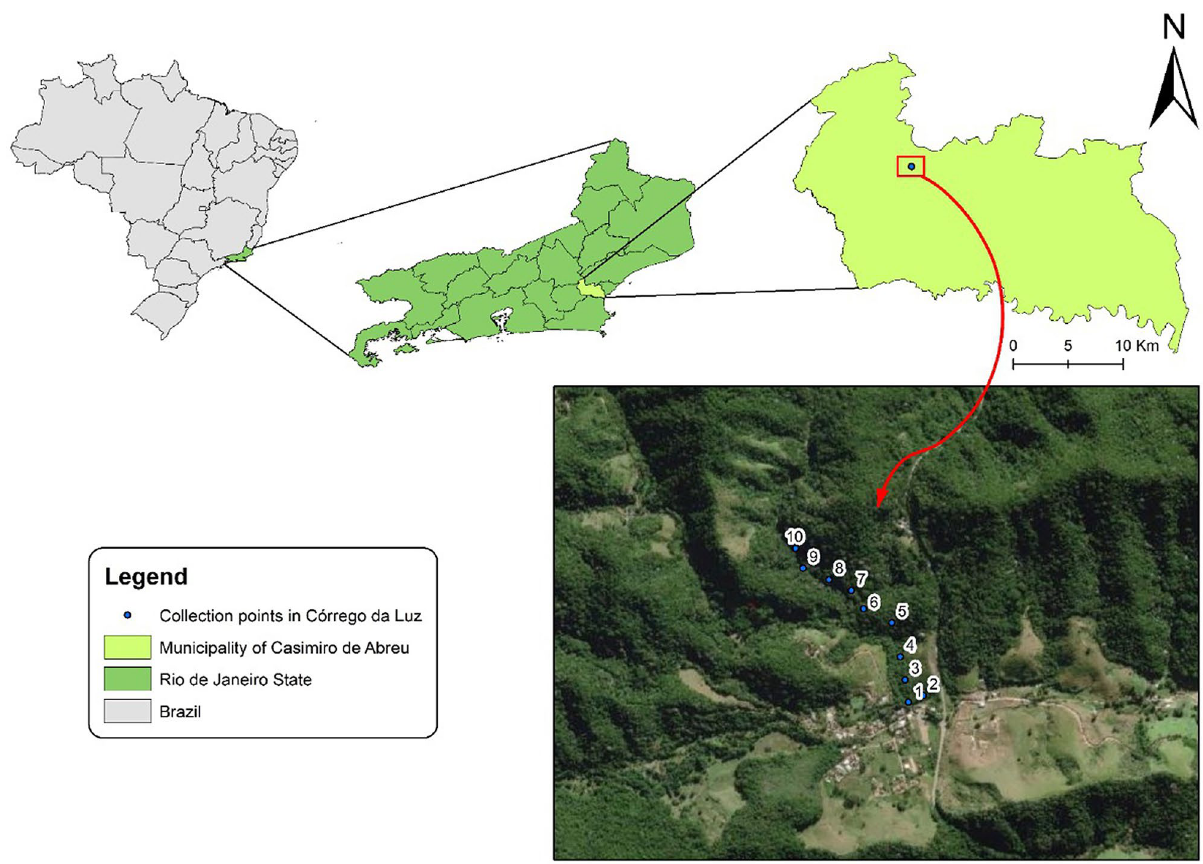
Figure 3. Sampling sites in the Córrego da Luz Municipal Park, located in the city of Casimiro de Abreu, Rio de Janeiro state, Brazil. Maps were prepared in ArcGIS Desktop: Release 10.5. Redlands, CA (ESRI) (https ://www. esri.com/en-us/arcgi s/produ cts/arcgi s-pro/overv iew/. Accessed: November